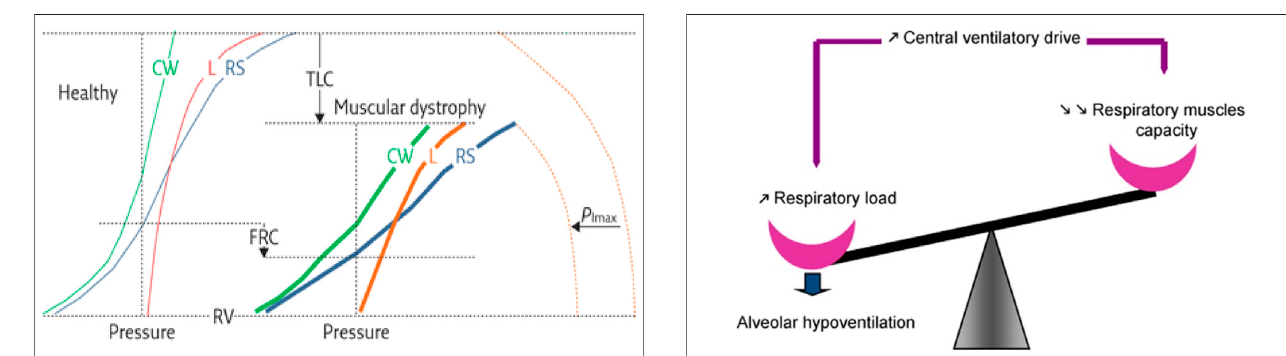
FIGURE 4 | Maintenance of spontaneous ventilation depends on balance between function of the respiratory muscles on one side and the respiratory load, determined by respiratory mechanics, on the other. Central respiratory drive isregulated such that work ofbreathing is minimized by adjusting tidal volume and respiratory rate to compensate for the load. Alveolar hypoventilation ensues when the respiratory load exceeds the ability of the central drive and respiratory muscles to maintain adequate gas exchange, often associated with respiratory muscle fatigue. From (Fauroux and Khirani,